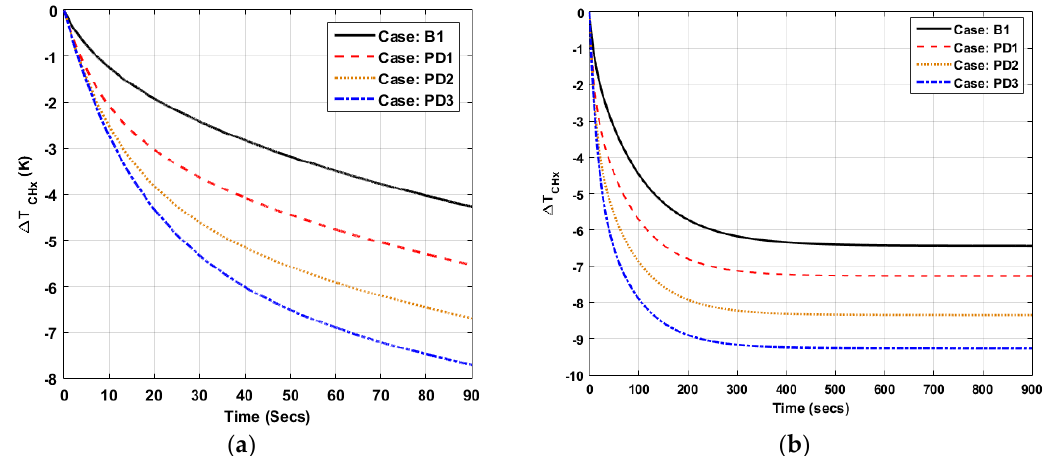
Figure 11. ∆𝑇 𝐶𝐻𝑥 profiles for different length combinations of multi-layered stack ( a ) calculated ( b ) Figure 11. ∆ T CHx profiles for di ff erent length combinations of multi-layered stack ( a ) calculated ( b ) steady state extrapolation. steady state